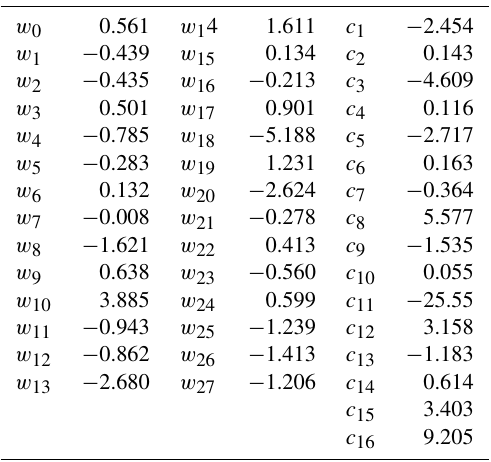
Table B1. Weights and coefficients for ANN calculation of NO